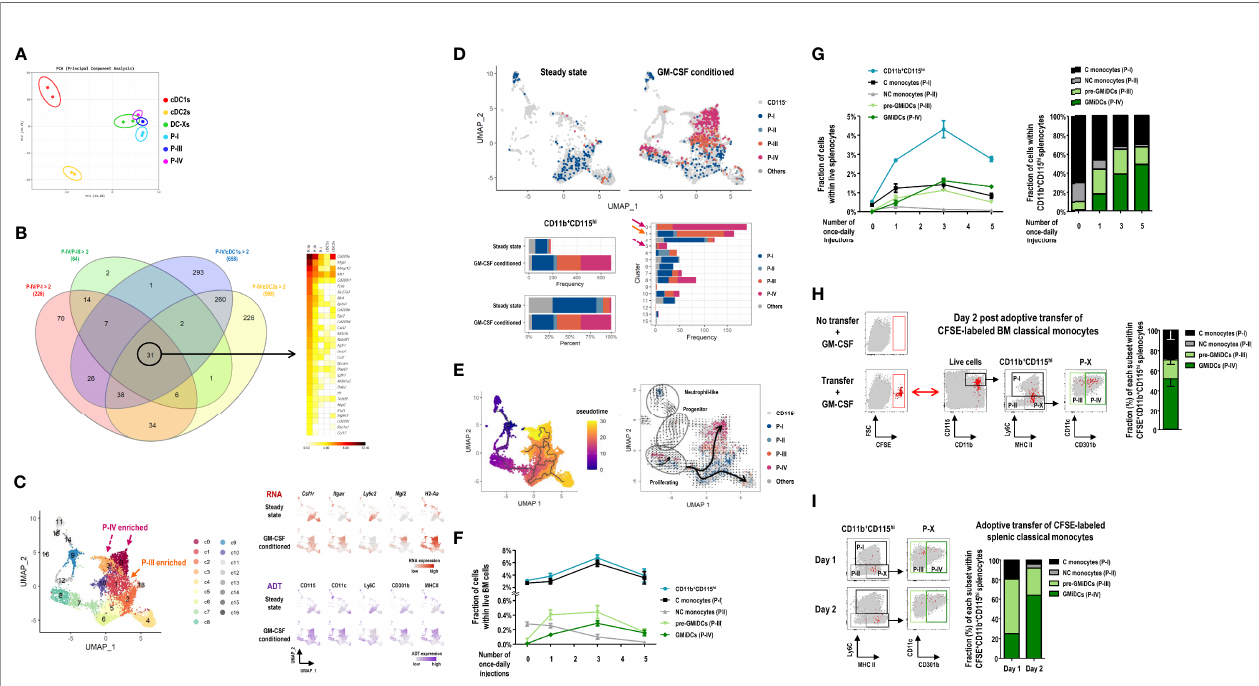
FIGURE 6 | Ly6C + classical monocytes differentiate into GMiDCs in the spleen. (A) PCA of transcriptomes of splenic cDC1s, cDC2s, DC-Xs, classical monocytes (C monocytes, P-I), P-III, and GMiDCs (P-IV) in GM-CSF-treated mice (n = 2 mice for each cell population). (B) Genes in each circle of Venn diagram (left) are expressed at least twice higher in the P-IV than the respective other populations. Heatmap (right) showing the 31 P-IV-enriched genes in descending order of expression. (C) Uniform manifold approximation and projection (UMAP) of 6,075 cells in the CD11b + splenocytes excluding T cells, B cells, granulocytes, neutrophils, and cDCs. Expression levels of 5 marker genes ( Csf1r /CD115 , Itgax /CD11c , Ly6c2 /Ly6C , Mgl2 /CD301b, and H2-A2 /MHCII) are detected by CITE-seq analyses. Each cell is colored by cluster (left), RNA expression level (right upper), or antibody-derived tag (ADT) level (right lower). (D) Constitution of P-I, P-II, P-III, P-IV, and other CD115 hi cells in the spleen of steady- state and GM-CSF-treated mice. UMAP (upper) and bar graphs (lower) are color-coded according to ADT-based CD115 hi cell subsets. (E) Pseudotemporal analyses showing pseudotime (left) estimated by Monocle3 with the cluster 9 (progenitor-like cells) assigned as root and RNA velocity (right) inferred by the velocyto pipeline with thick arrows representing the directional fl ow of thin velocity arrows. (F, G) Changes in the fractions of CD11b + CD115 hi cells and their subsets, i.e., C monocytes (P-I), non-classical (NC) monocytes (P-II), pre-GMiDCs (P-III), and GMiDCs (P-IV) in the BM (F) and the spleen (G) analyzed at 24 hours after different numbers of once-daily injections of GM-CSF. Data are shown in mean ± SEM (n = 4 mice for each condition). (H, I) Flow cytograms and graphs showing CFSE + cells in the splenic CD11b + CD115 hi cell subsets of GM-CSF-treated mice after the adoptive transfer of CFSE-labeled classical monocytes isolated from the BM (H) and the spleen (I) . CFSE + cells (red dots) in the spleen are backgated in a series of dot plots of total live-gated cells (gray dots) to identify CD11b + CD115 hi cell subsets (left panels). Graphs (right) showing mean ± SEM ( H, n = 3 mice) or mean ( I, n = 2 mice for each condition) of the fraction for each cell